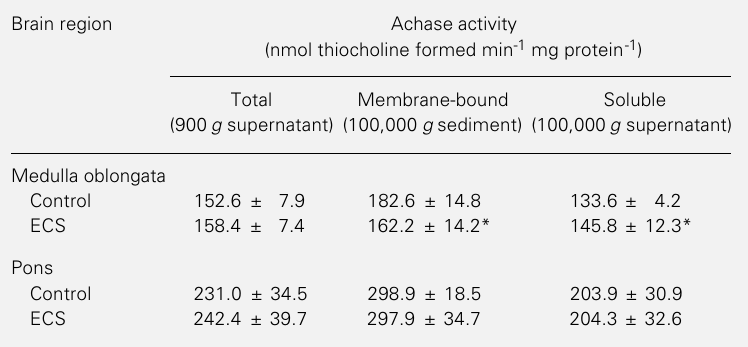
Table 1 - Specific activity of Achase in the medulla oblongata and pons of rats after chronic ECS treatment. Rats received one ECS daily for 7 days and were sacrificed 24 h after the last ECS. Achase was assayed using acetylthiocholine as the substrate. Data are reported as mean ± SD (N = 5 for all measurements). *P<0.05 compared to control (Student t